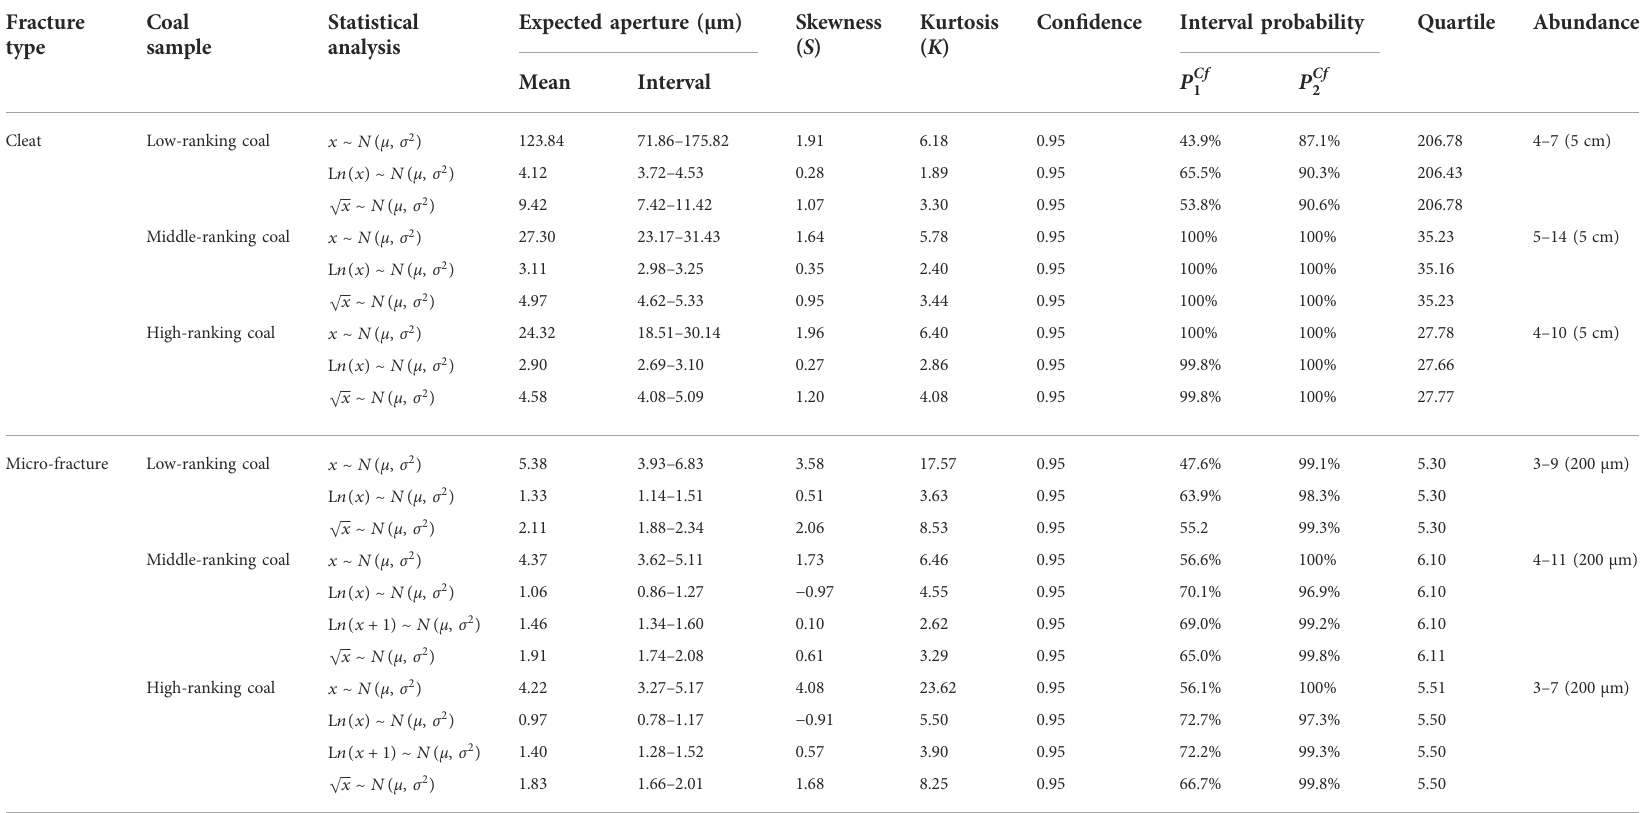
TABLE 4 Summary of fracture aperture goodness-of- fi t statistics of coal with different ranks. Fracture type